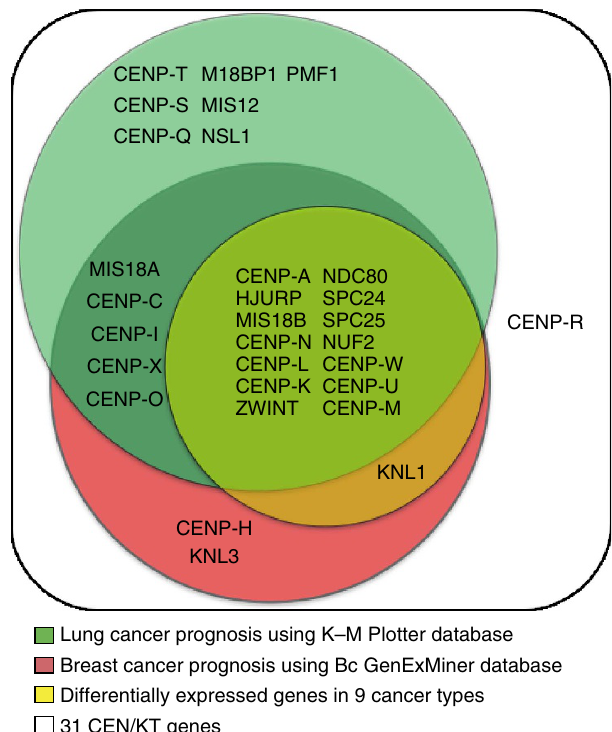
Figure 2 | Venn diagram identifies 14 CEN/KT genes whose expression levels correlate with cancer progression. White: All 31 CEN/KT genes. Yellow: CEN/KTgenes that are differentially expressed in nine cancer types relative to their corresponding normal tissues as shown in Fig. 1b. Red: CEN/KTgenes with significant prognostic values for breast cancer patients using BC-GenExMiner, and (green) those with significant prognostic values for lung cancer patients using K–M Plotter based on Affymetrix HG-U133A platform. Note that inclusion of five genes ( CENP-W , CENP-K , CENP-L , NUF2 and SPC24 ) in the final core CEN/KTgene list was based on the upregulated gene list and BC-GenExMiner results (also see